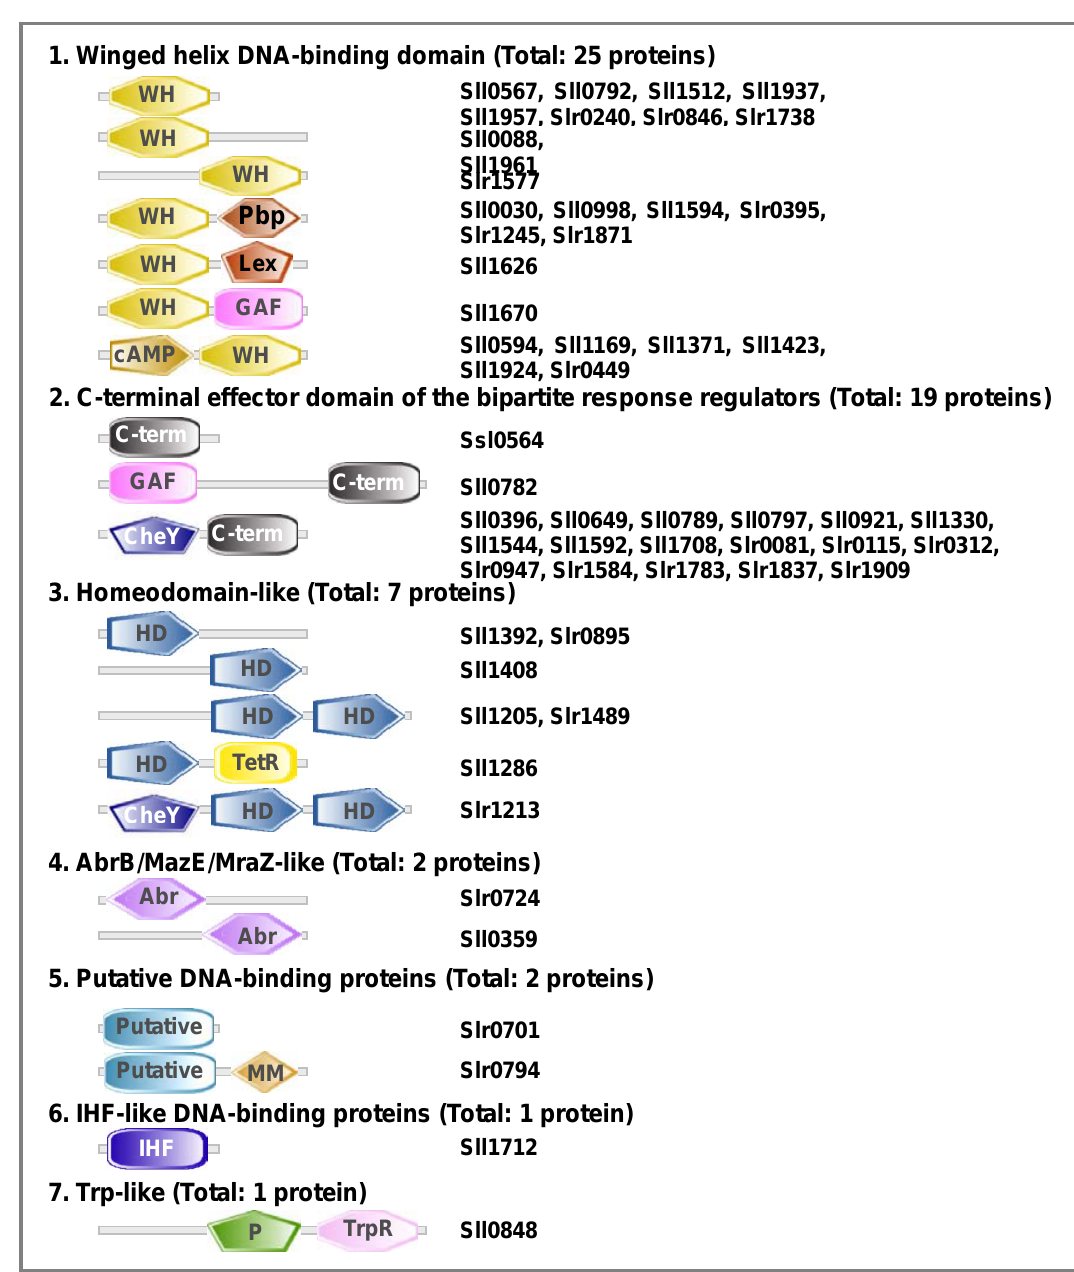
Figure 7. Transcription factors of Synechocystis classified according to the specific architecture of their DNA-binding domais. WH -"Winged helix" DNA-binding domain; C-term -C-terminal IHF -IHF-like DNA-binding proteins; TRP -TrpR-like; Pbp -Periplasmic binding protein-like II; GAF -GAF domain; cAMP -cAMP-binding domain-like; Lex -LexA/Signal peptidase; MM -Precorrin-8X metylmutase; P